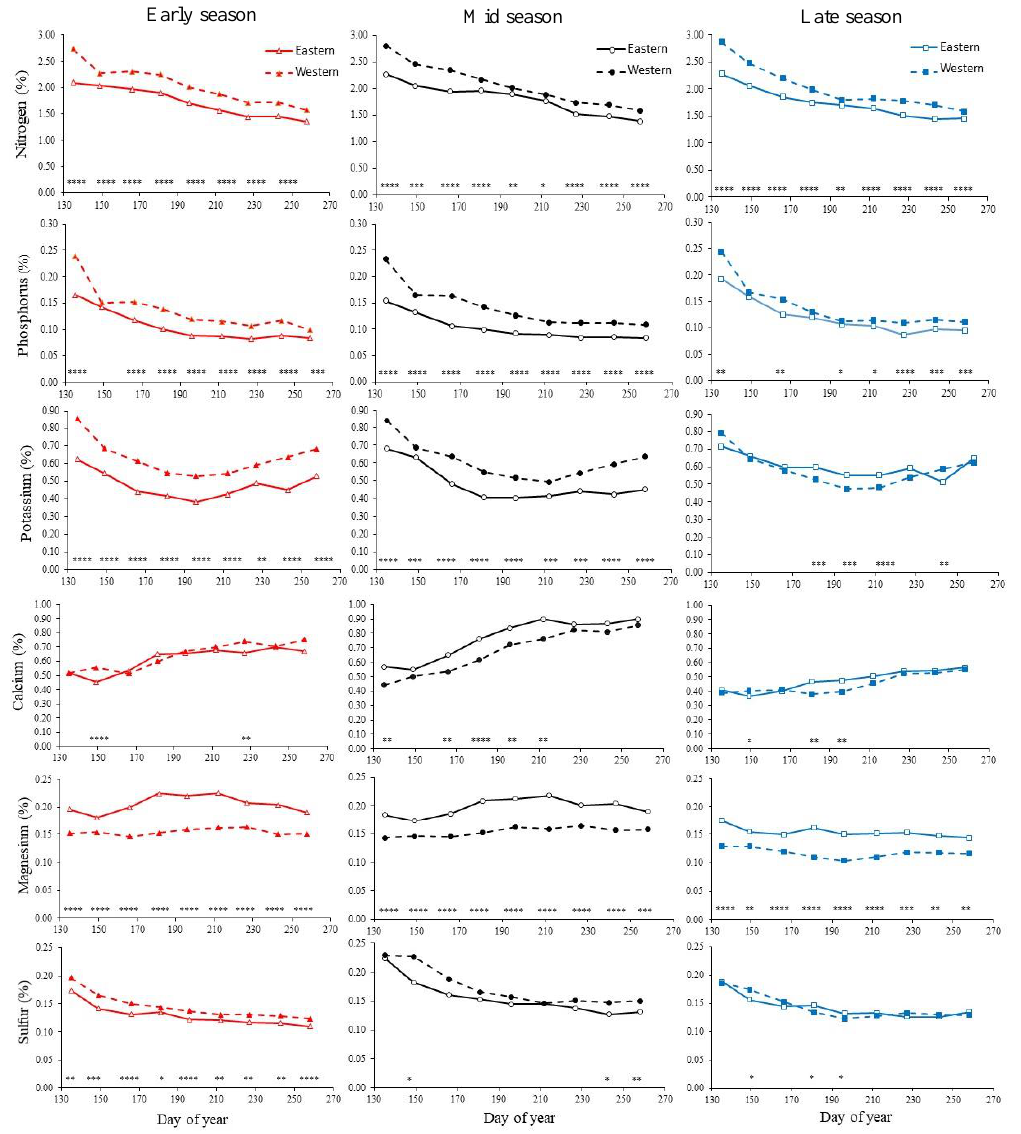
Figure 1. Concentrations of N, P, K, Ca, Mg, and S in recently expanded leaves of early-, mid-, and late-season cultivars of northern highbush blueberry in eastern and western Washington. Data are averaged over 3 years (2015 –2017). ‘Duke’ w as the early- season cultivar, ‘Draper’ the mid -season cultivar, and ‘Aurora’ and ‘Liberty’ the late -season cultivars in eastern Washington and western Washington, respectively. Each symbol represents the mean of the three field per cultivar in western Wash ington and four fields of ‘Duke’ and two fields each of ‘Draper’ and ‘Aurora’ in eastern Wash- ington. Asterisks denote significance with: **** <0.0001, ***<0.001, **<0.01, and *<0.05. Soil test results (Table 2) showed higher soil pH in eastern Washington than western Washington in all three years, while contrasting trends were observed in soil OM. Soil Ca and Mg in eastern Washington were also higher than in western Washington throughout the study. Soil K and Na were similarly higher in eastern Washington than western Wash- ington for all three years. Time of sampling influenced soil pH, S, and Na in 2015; and soil